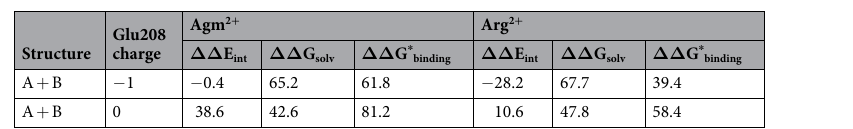
Table 5. Free energies of binding calculated using MM-PBSA. Difference in binding free energy not including the configurational entropy contribution ( ΔΔ G * binding ), total solvation energy ( ΔΔ G solv ), and gas-phase interaction energy ( ΔΔ E int ) for Arg 2 + and Agm 2 + , with respect to Arg + used as a reference. All energies were averaged for the two monomers (A and B) and computed for both Glu208 protonation states. All energy values are given in kcal/mol. Standard errors are given in Table